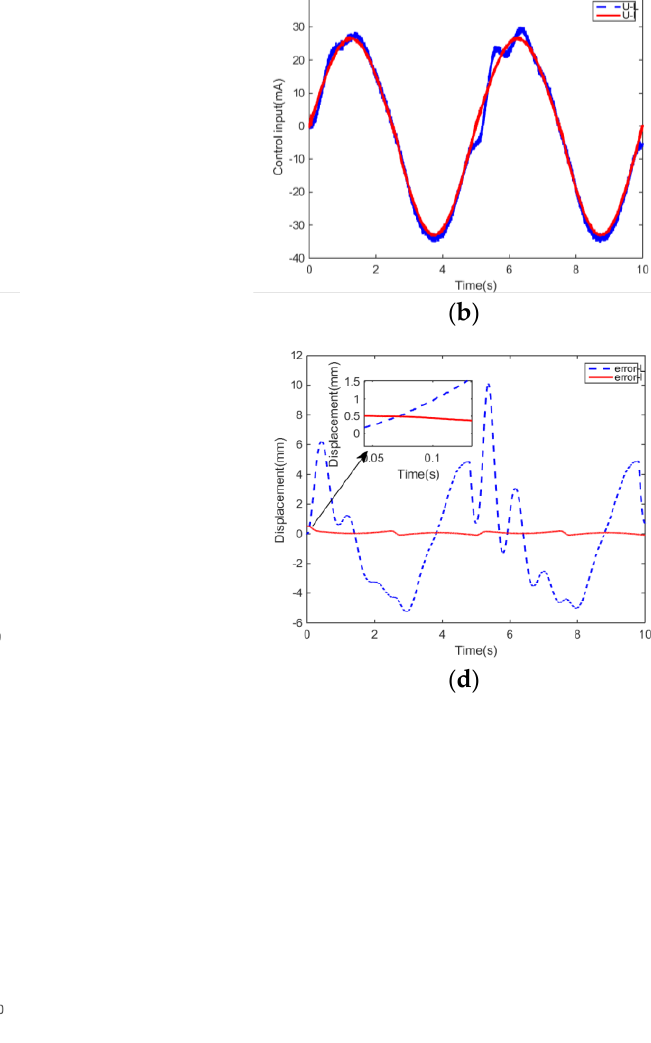
Figure 5. Experimental results of the proposed method and the traditional LADRC method for tracking sinusoidal trajectory; ( a ) Comparison of tracking performance; ( b ) Comparison of control inputs; ( c ) Comparison of perturbation estimation; ( d ) Comparison of tracking errors; ( e ) External load force.